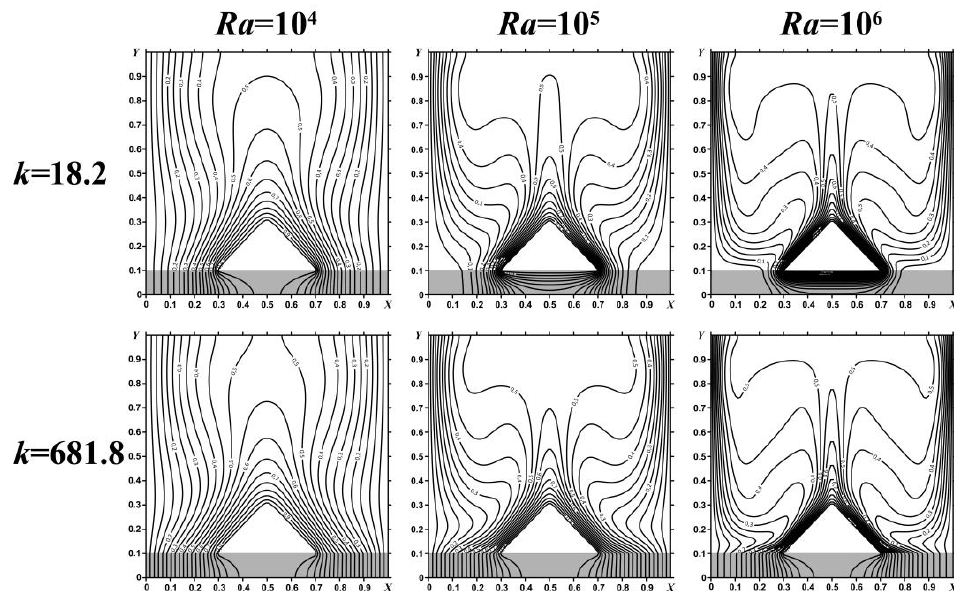
Figure 7. Isotherms for a triangular heater for different Ra and k.